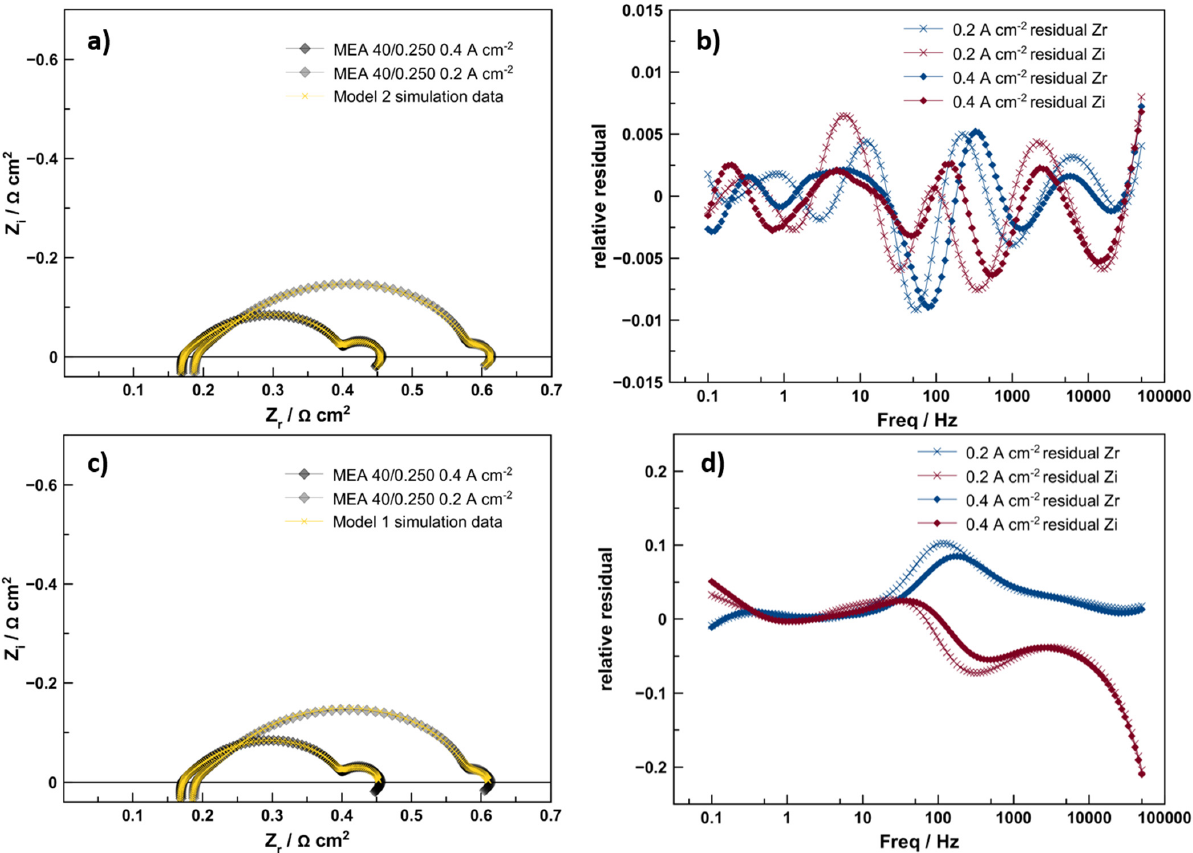
Figure 6. Selected experimental and simulated curves including residuals at 0.2, 0.4 of Model 2 ( a,b ) and Model 1 ( c,d ). The residuals show that Model 1 is not suited for simulating low-frequency signals, while Model 2 can simulate signals over the entire measured frequency spectrum. The complete set of experimental EIS—data and numerical residual analysis can be found in the supporting information (Figures S1–S5 in the Supplementary Materials).